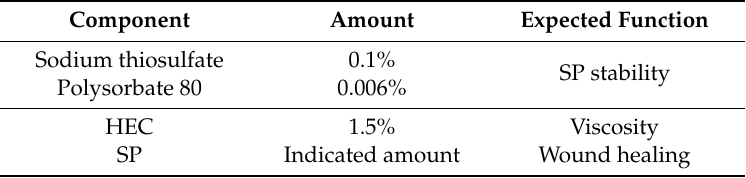
Figure 1. Ratios of sodium thiosulfate and polysorbate 80 in the SP gel formulation. Sodium thiosulfate and polysorbate 80 ratios in SP gel were determined by analyzing the SP content in the 5 µ g/mL SP solution containing sodium thiosulfate and polysorbate 80 by ELISA. Values represent mean ± SD of three independent experiments. *** p < 0.001. Table 1. SP gel formulation.